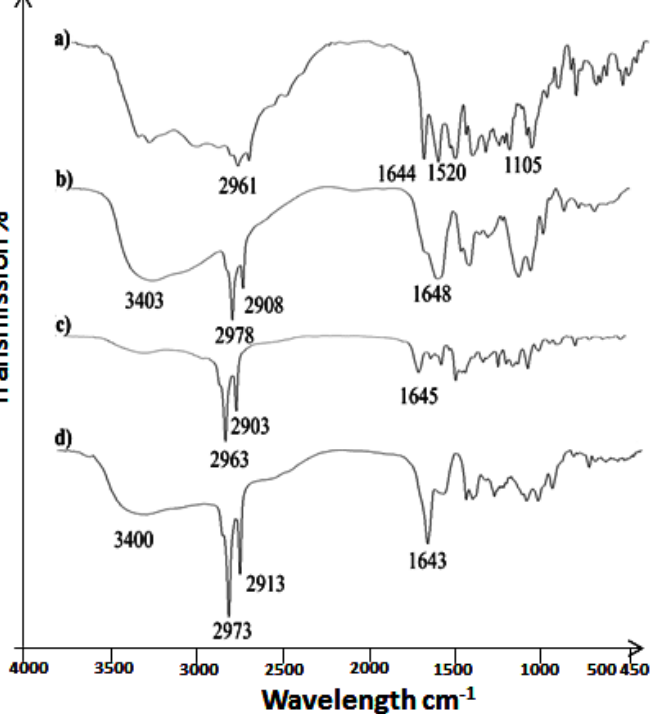
Figure 1. FTIR spectra of ( a ) drug, ( b ) chitosan, ( c ) Formulation C1 and ( d ) Formulation C2.